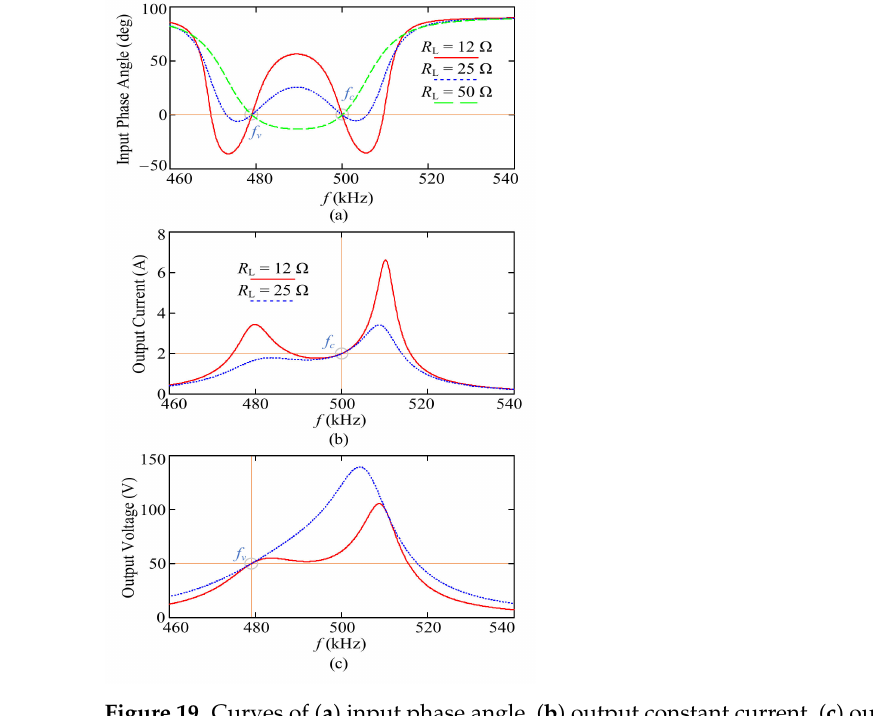
Figure 19. Curves of ( a ) input phase angle, ( b ) output constant current, ( c ) output constant voltage versus the operating frequencies at CC/CV